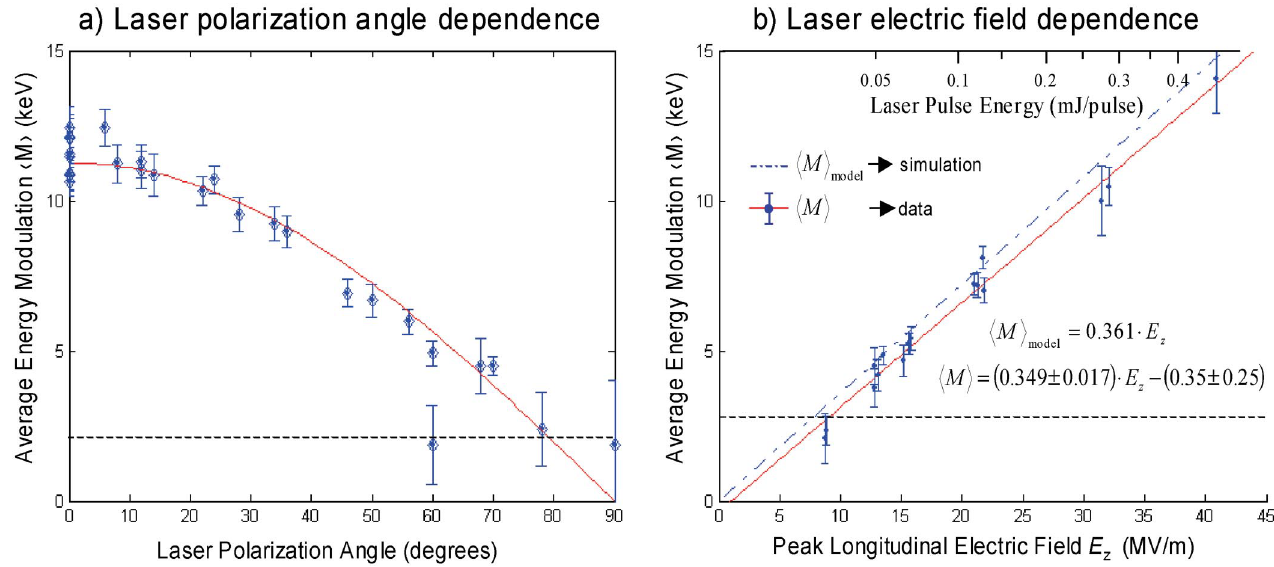
FIG. 11. (Color) (a) Dependence of the average energy modulation h M i on the laser polarization angle. The red curve is a cosine function fit to the data. (b) Dependence of the average energy modulation h M i on the laser peak electric field. The red line is a linear fit to the data. The dashed lines in both plots show the noise floor